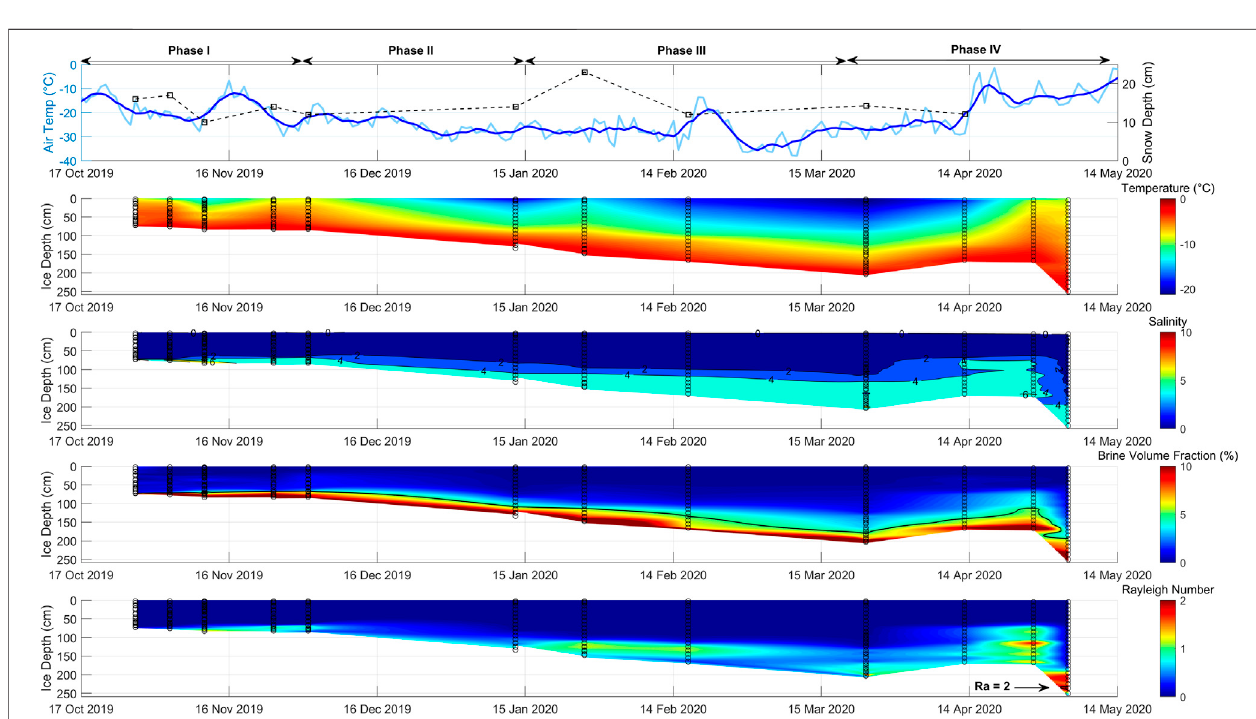
FIGURE7| The evolutionofphysical properties at themaincoringsecond-year ice site. See Figure3 captionforadescription ofcommon labels and annotations. The relatively fresh SYI layer thickness above new ice growth varied spatially. The ice thickness trend is affected by both temporal and spatial variability.